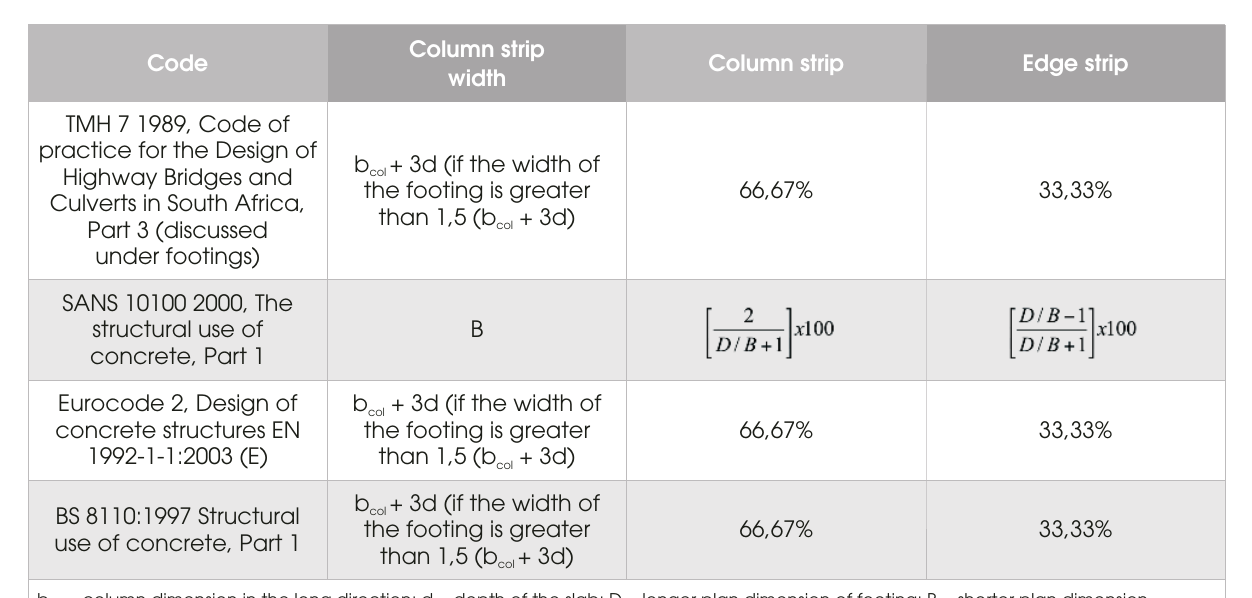
Column strip Edge